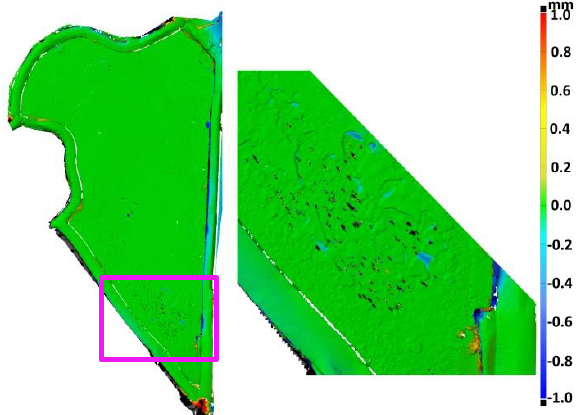
Figure 7. Overview and detail of the 3D inspection of a single glass pane from nII , Koszewko.